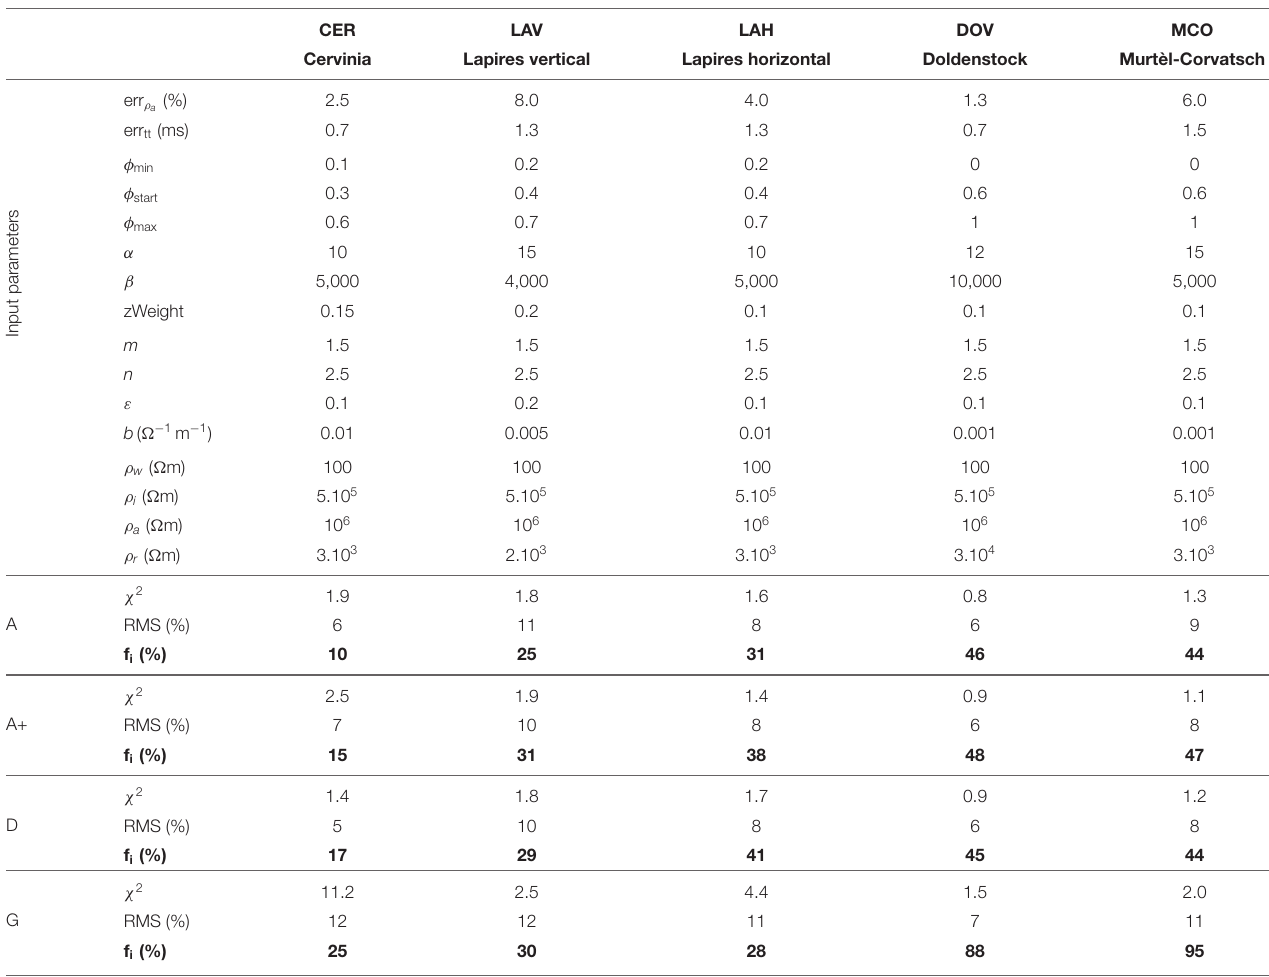
TABLE 2 | Summary of selected parameters for each profile. CER LAV LAH DOV MCO Cervinia Lapires vertical Lapires horizontal Doldenstock